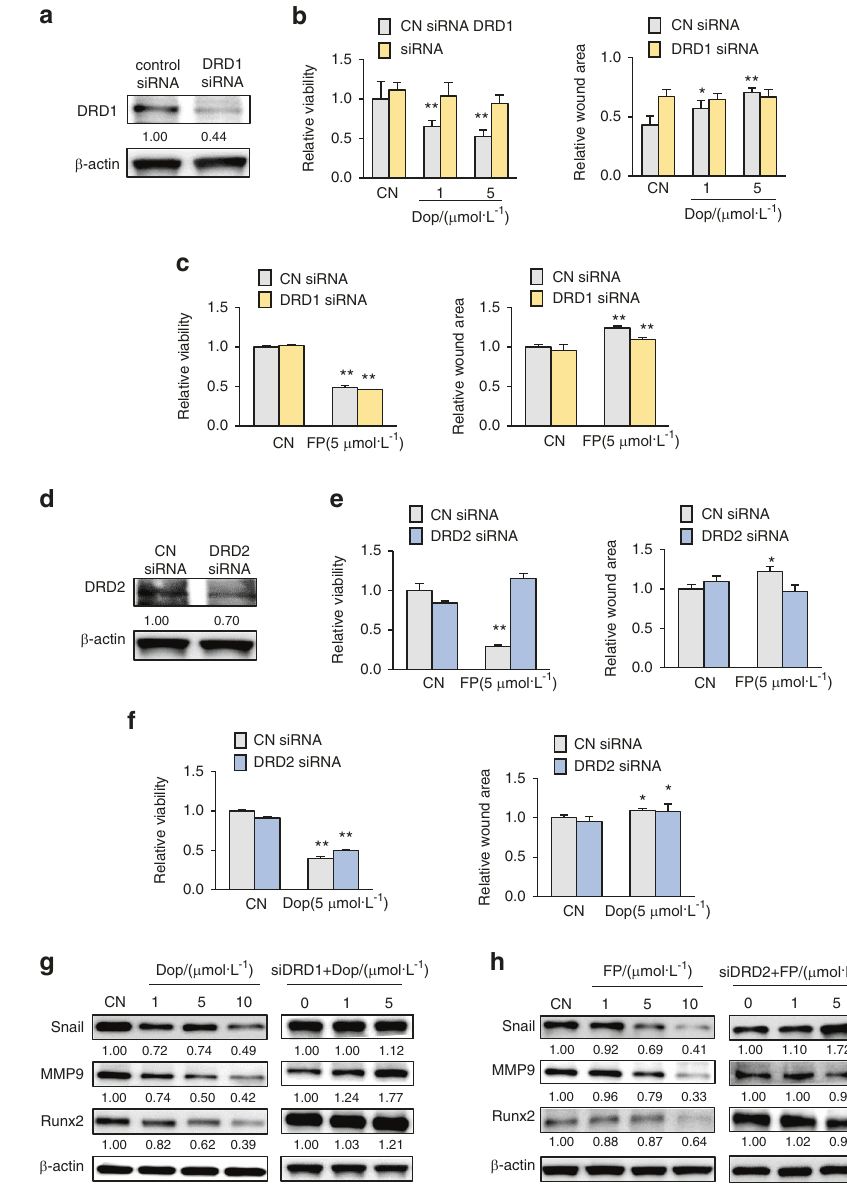
Fig. 4 Role of two dopamine receptors (DRD1 and DRD2) in the responses to dopamine and fl uphenazine in 4T1Br cells. CN control, Dop dopamine, FP fl uphenazine, siDRD1 DRD1 siRNA, siDRD2 DRD2 siRNA. The single and double asterisks indicate P < 0.05 and 0.01, respectively. a – c Suppression of dopamine-driven inhibition of MTT-assessed viability and scratch assay-measured migration upon the silencing of DRD1. The inhibitory effect of FP was not altered by DRD1 silencing. d – f Suppression of the FP-driven inhibition of MTT-assessed viability and scratch assay-measured migration upon the silencing of DRD2. The inhibitory effect of dopamine was not altered by DRD2 silencing. g Dopamine- driven downregulation of Snail, MMP9, and Runx2, and the abolishment of their downregulation by DRD1 silencing. h FP-driven downregulation of Snail, MMP9, and Runx2, and the abolishment of their downregulation by DRD2